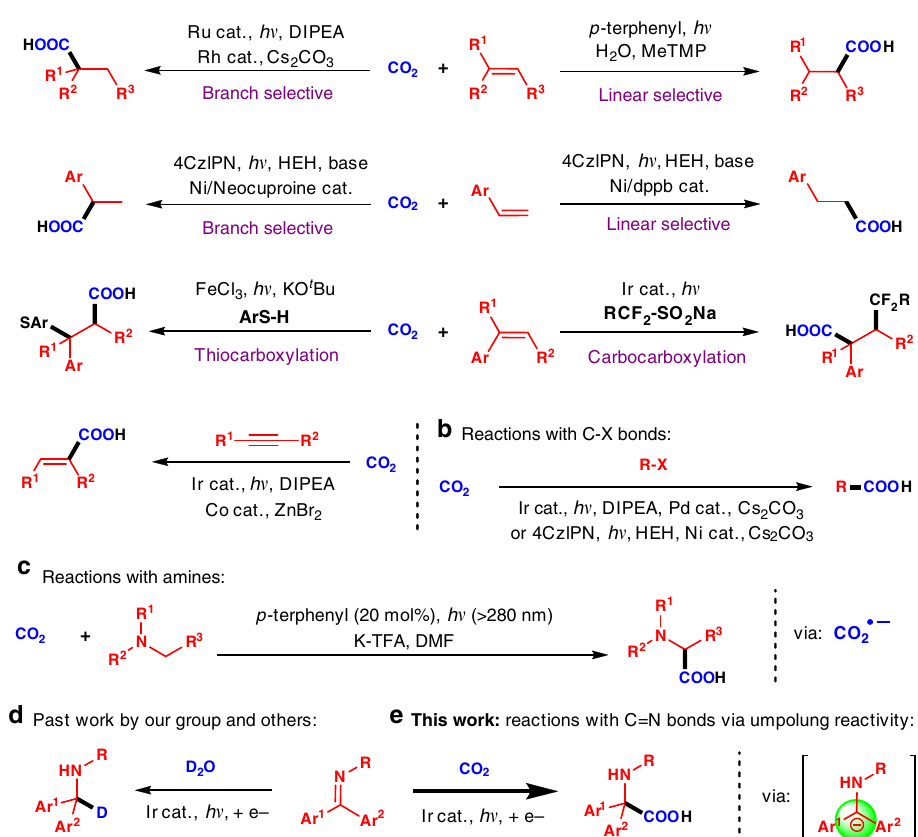
Fig. 1 Fixation of CO 2 under photoredox catalysis. a Reaction of CO 2 with ole fi ns and alkynes. b Reactions of C – X bonds with CO 2 . c C – H functionalization of amines with CO 2 . d Past work by our group and Polyzos. e Unpolung hydrocarboxylation of C = N bonds with CO 2 (this